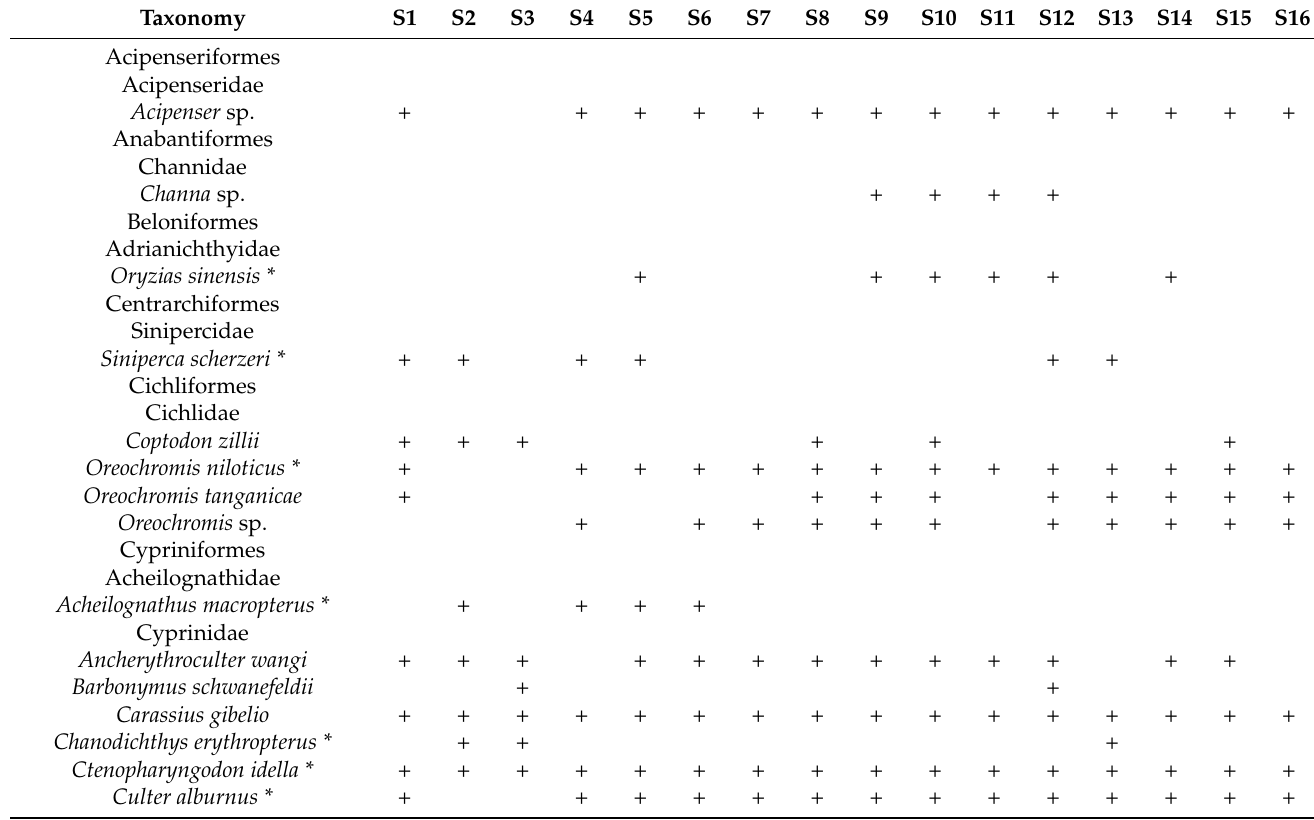
Table 2. Summary of fish identified by eDNA from the Wanfeng